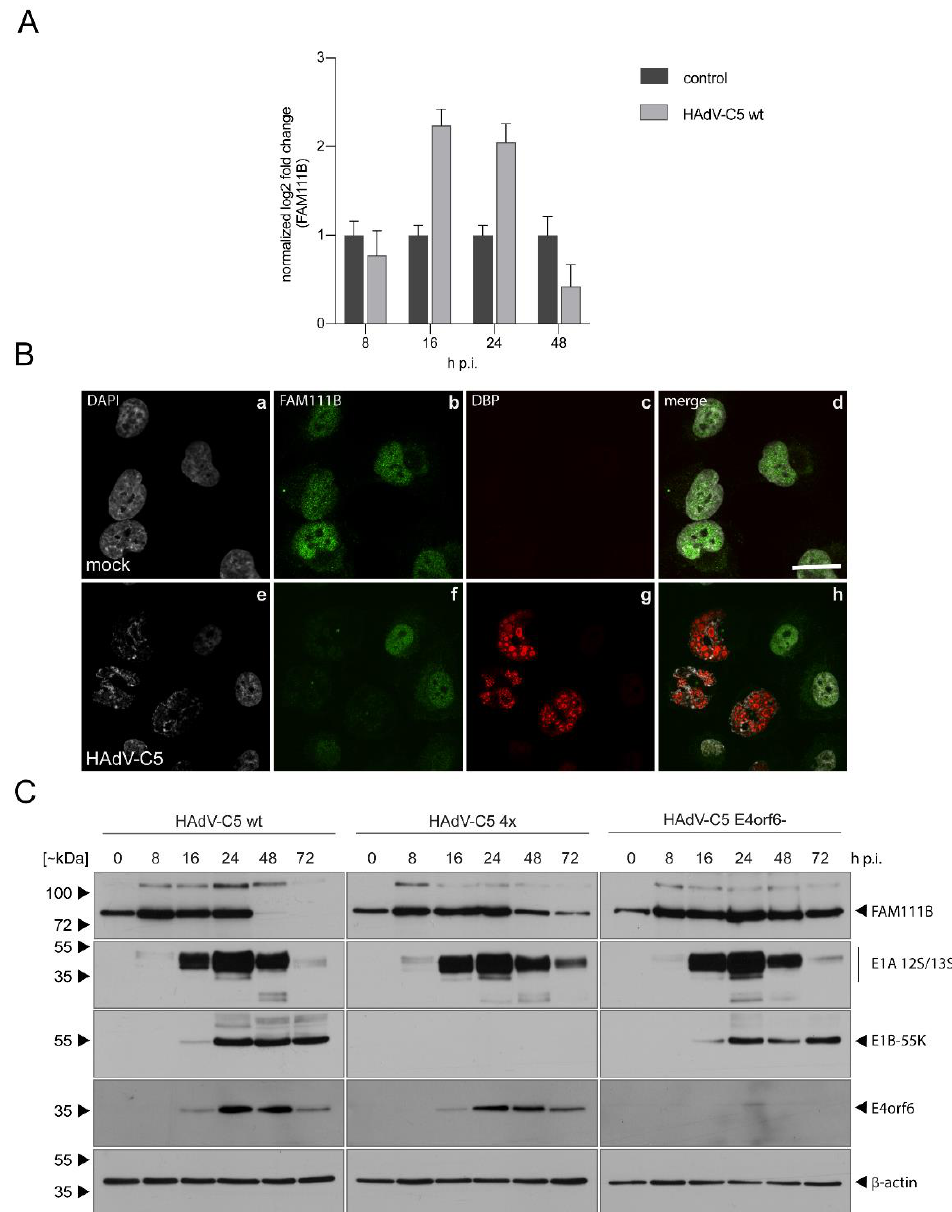
Figure 1. FAM111B transcript and protein levels are differentially regulated during infection. Subconfluent ( A , B ) A549 cells or ( C ) H1299 cells were left uninfected (mock) or infected with HAdV-C5 (MOI 20) and harvested at indicated time points. ( A ) Total RNA was extracted and reverse transcribed and resulting cDNA was amplified with primer pairs specific for FAM111B or cellular GAPDH by RT-PCR ( ∆∆ Ct). The experiment was done in two triplicates. Representative FAM111B mRNA amounts are shown normalized to GAPDH. Error bars indicate standard error of mean. ( B ) Cells were fixed with 4% PFA at 24 h p.i. DBP was visualized as infection control with a mouse mAb B6-8 ( α -DBP). FAM111B was visualized using the rabbit FAM111B pAb HPA038637. Primary antibodies were detected with secondary antibodies conjugated to Alexa 488 (green) or Alexa 555 (red), and nuclei were stained with DAPI. Representative staining patterns of >30 analyzed cells and overlays of the single images are shown. The scale bar in (d) corresponds to 10 µ m. ( C ) H1299 cells were infected with wt HAdV-C5, E1B-55K-deleted (4 × ) and E4orf6-deleted (6-) viruses (MOI 20) and harvested at indicated time points. Total cell lysates were resolved by SDS-PAGE and visualized by immunoblotting. Proteins were detected using pAb HPA038637 ( α -FAM111B), mAb M73 ( α -E1A), mAb 2A6 ( α -E1B-55K), mAb RSA3 ( α -E4orf6) and mAb AC-15 ( β -actin). Molecular masses in kilodaltons (kDa) are indicated on the left, while corresponding proteins are indicated on the right. Mock is indicated as 0 h p.i.